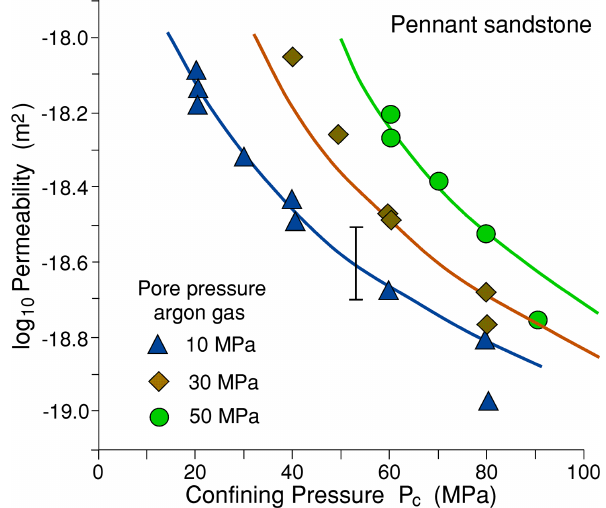
Figure 10. Gas permeability data for Pennant sandstone normal to layering, for three constant pore pressures. The three continuous curves are for Eq. (19) non-linear least-squares fits to the data.